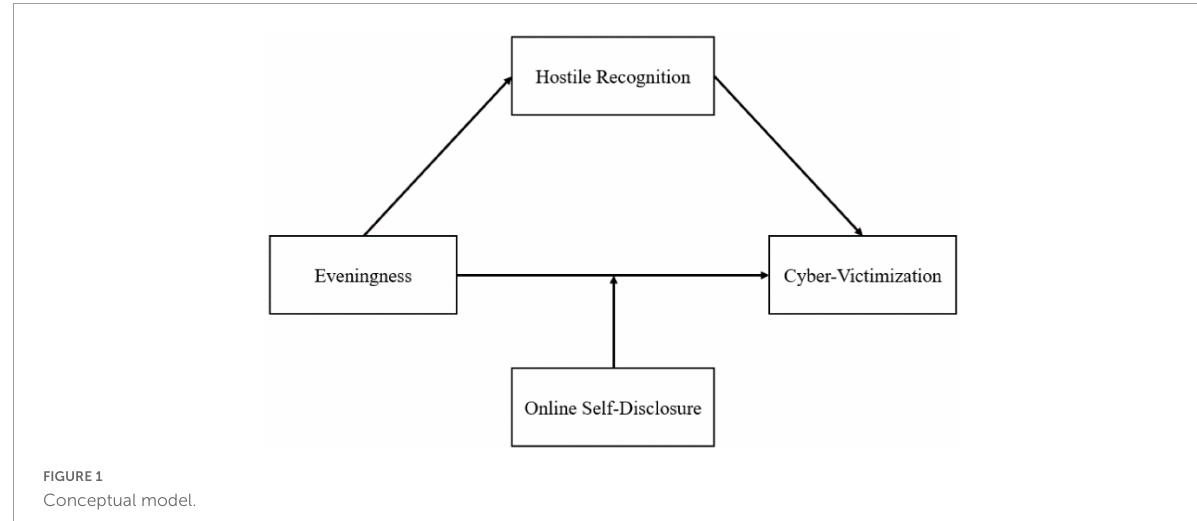
FIGURE1 Conceptual model.